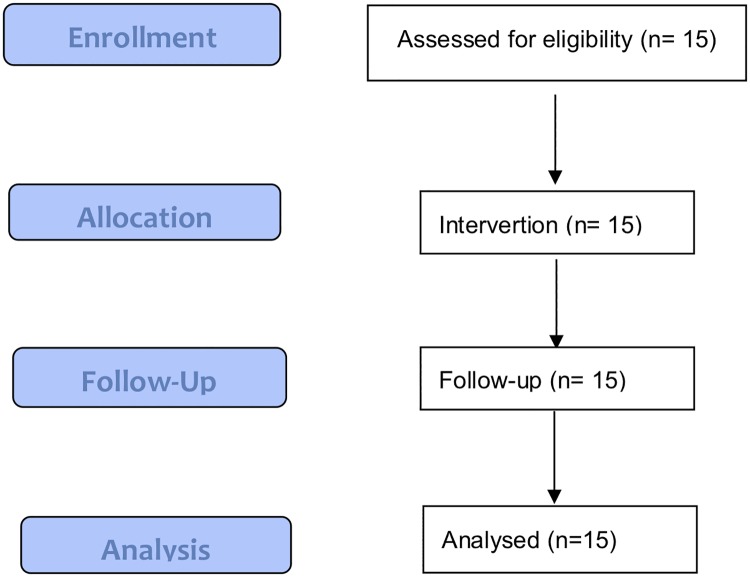
Study flowchart.